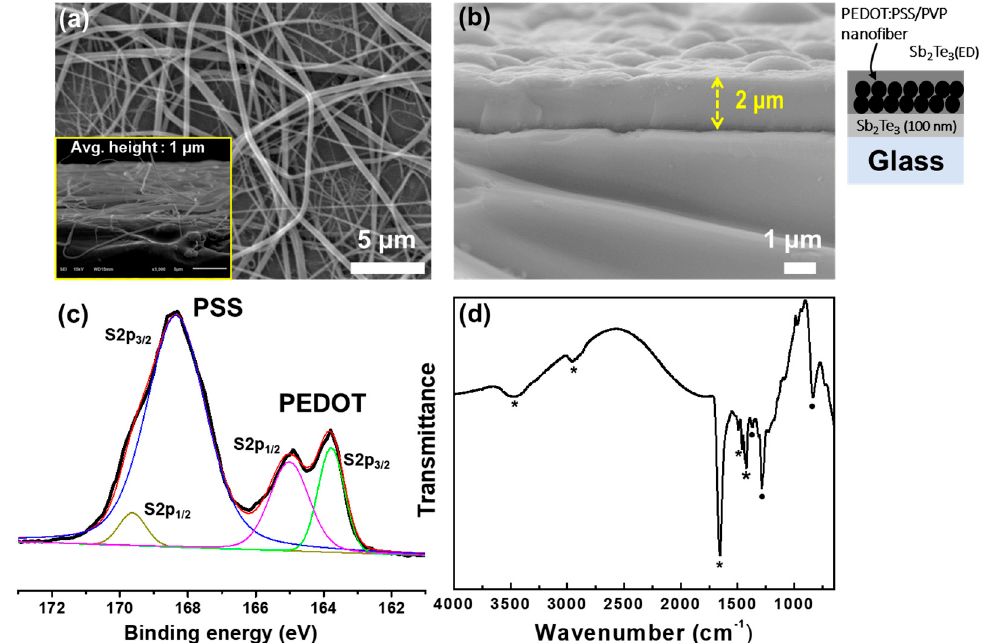
Figure 4. SEM of the ( a ) top view of the Sb 2 Te 3 /PEDOT:PSS-PVP composite film and ( b ) cross-sectional view after fully compositing the Sb 2 Te 3 / PEDOT:PSS-PVP / Sb 2 Te 3(ED) film. ( c ) XPS spectrum (black line) and deconvoluted S 2 p peaks for the PEDOT:PSS-PVP fibers. ( d ) FT-IR spectrum of the Sb 2 Te 3 / PEDOT:PSS-PVP / Sb 2 Te 3(ED) composite film.